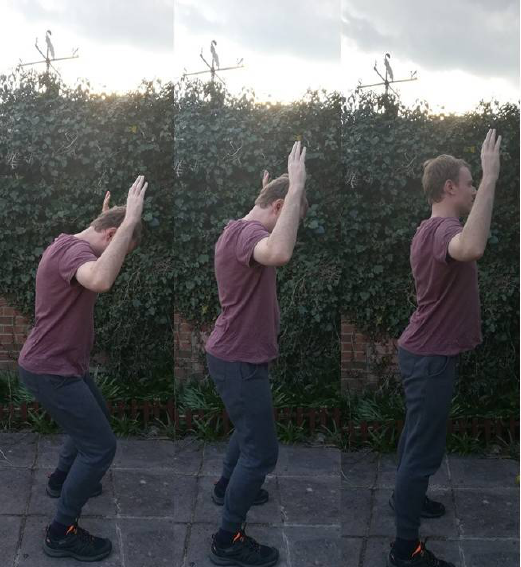
Figure 1. The Spinal Wave